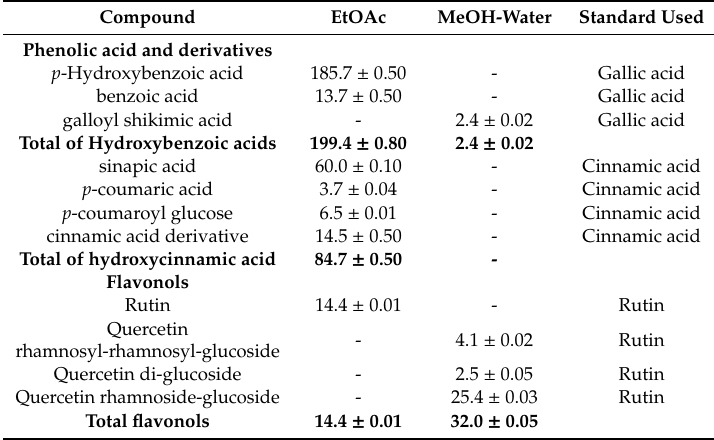
Table 7. Semi-quantification of polyphenols detected in Z. lotus fruits in µ g / 100 mg ( w / w